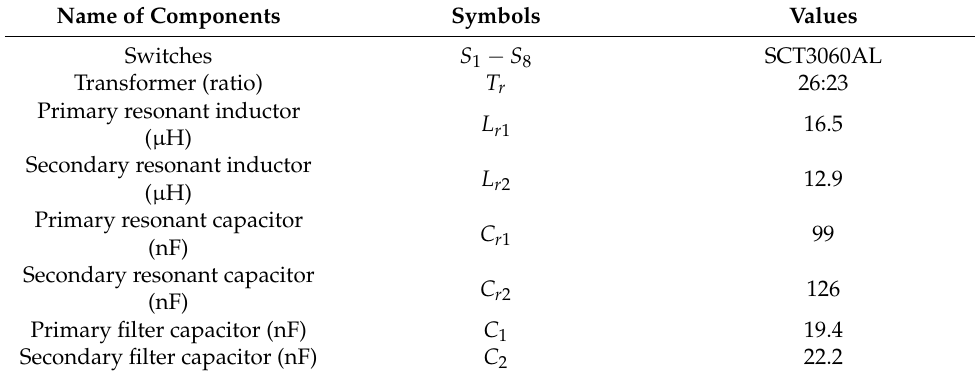
Table 2. Main component